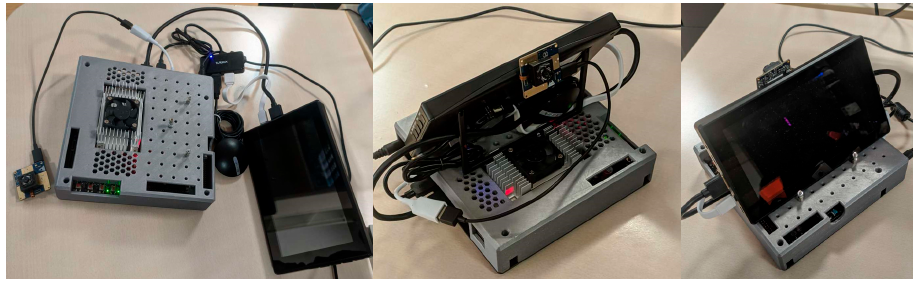
Figure 6. Packaging of the edge device for the